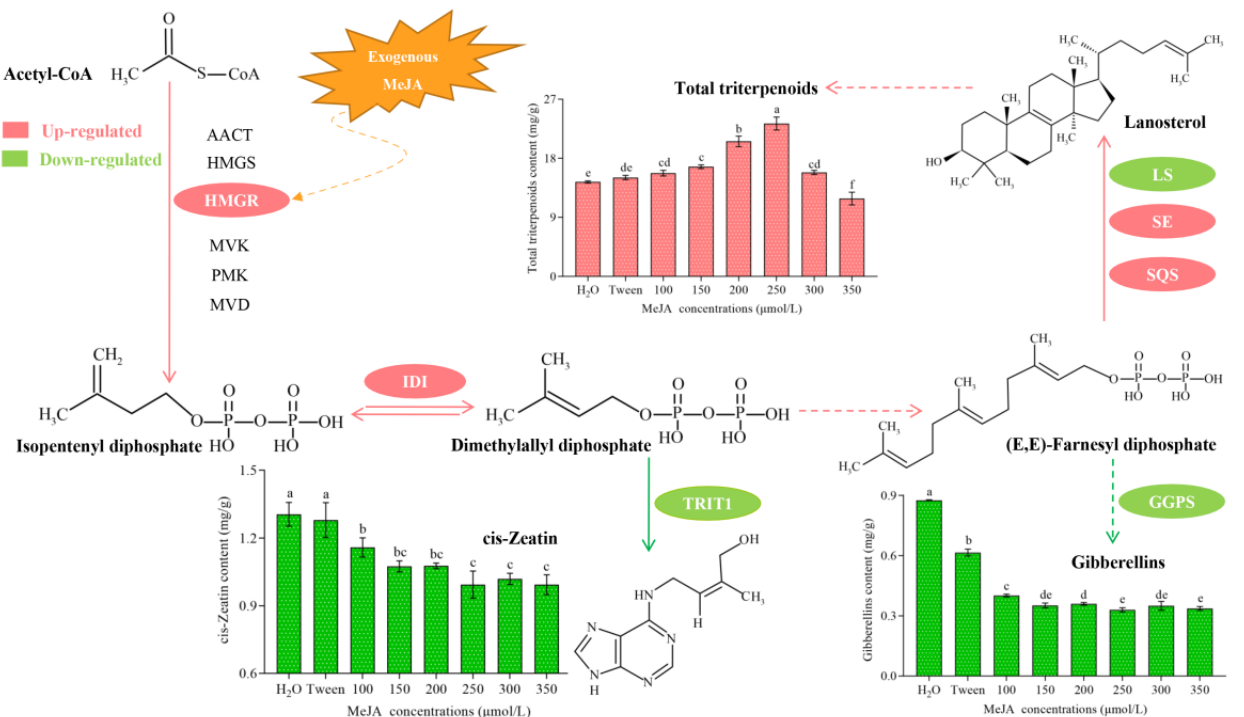
Figure 1. The mevalonate (MVA) biosynthetic pathway and changes in the contents of total triterpenoids and two terpenoid hormones (cZ and GAs) in response to treatment with different concentrations of MeJA. The mean difference being significant at the 0.05 level, p < 0.05.